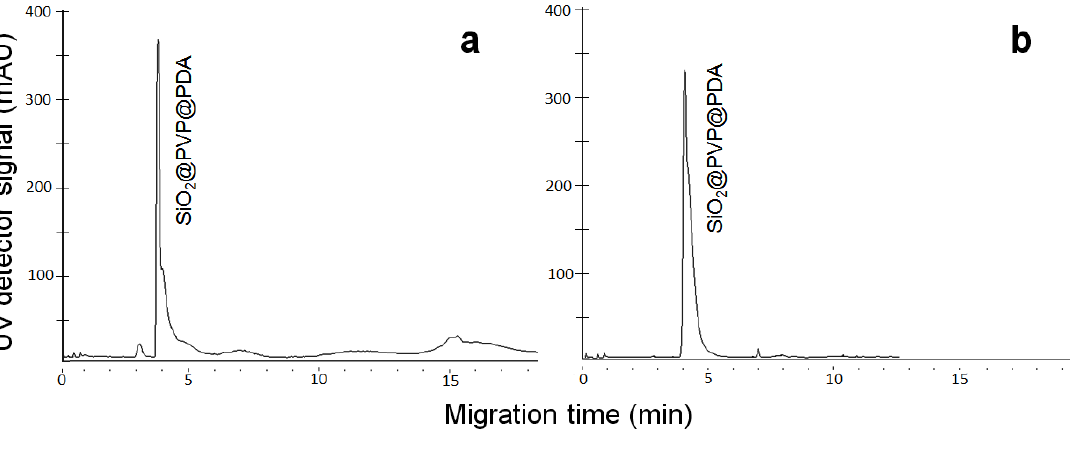
@PVP@PDA particles prepared using 10 mg 2 , 10 g/L of DA, 60 µL of 1.5 M NaOH, and either 2